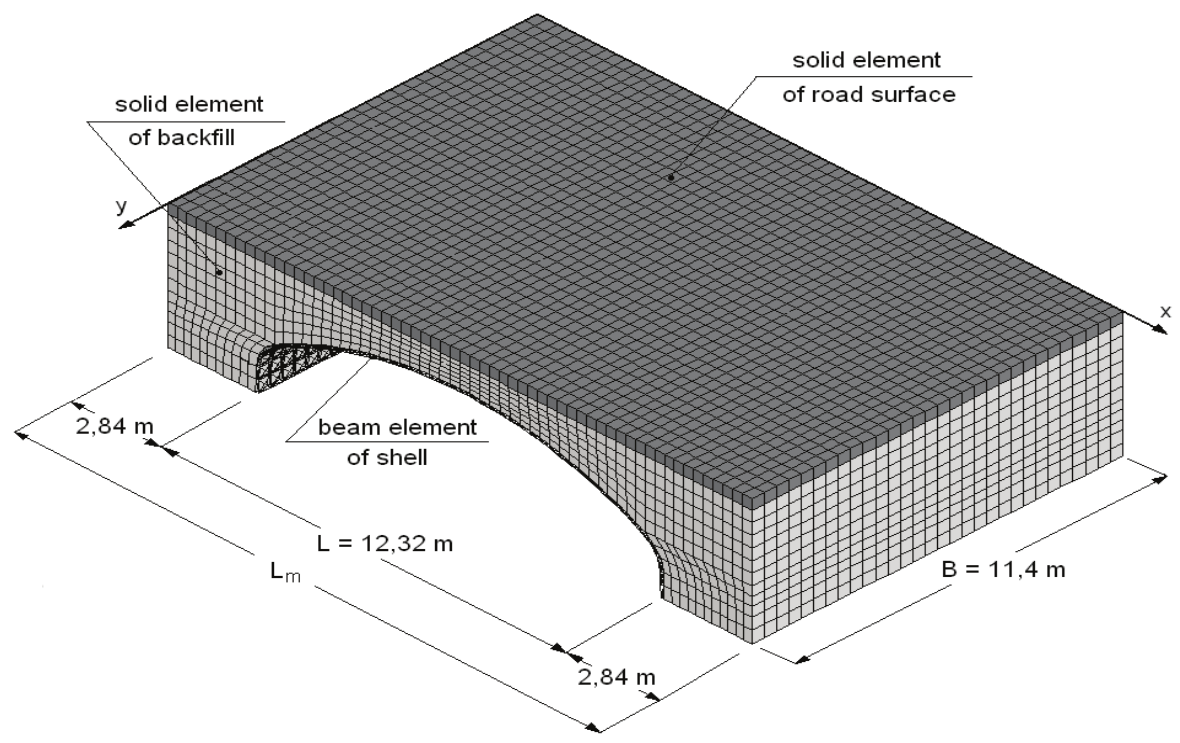
Figure 2: Model of soil–steel structure geometry Fig. 2